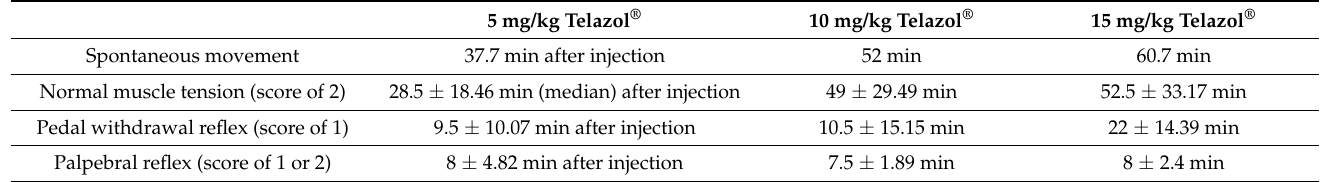
Table 3. Results of the assessments to determine the depth of sedation or